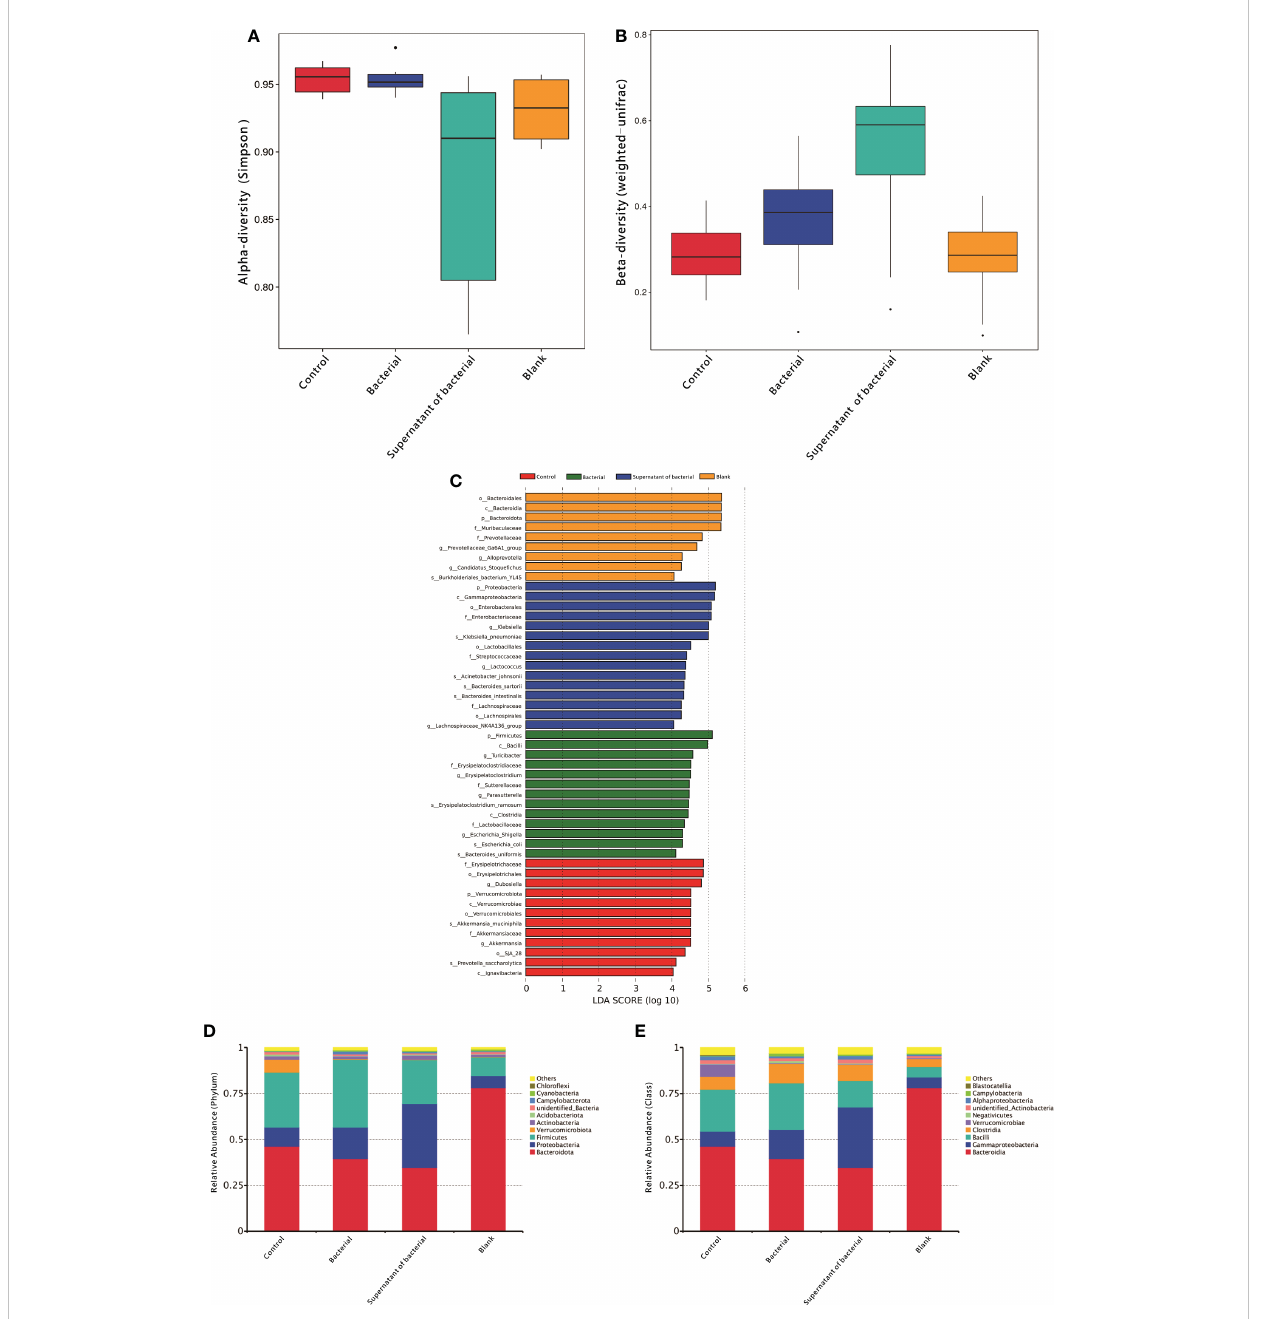
FIGURE 2 Analysis of gut microbiota in mice. (A) Alpha-diversity using the Simpson scale to measure the species richness and evenness. (B) Blpha-diversity using weighted_unifrac scale to measure distribution of different sequences. (C) LDA of gut microbiota among different groups. (D) Measuring the abundance of dominant micro fl ora among different groups at the phylum level. (E) Measuring the abundance of the dominant micro fl ora among different groups at the class